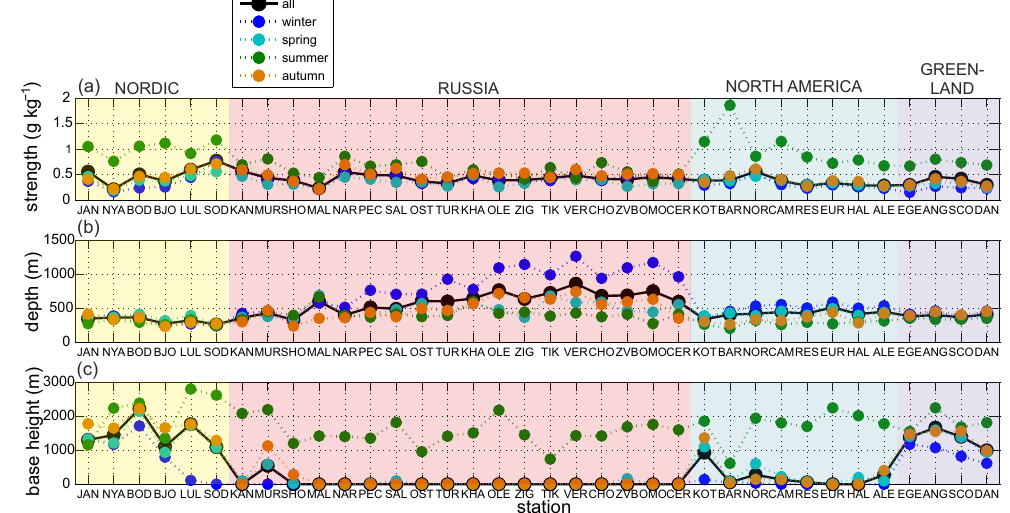
Fig. 4. (a) Median strength, (b) median depth and (c) median base height of the strongest humidity inversion in a profile in clear-sky conditions.